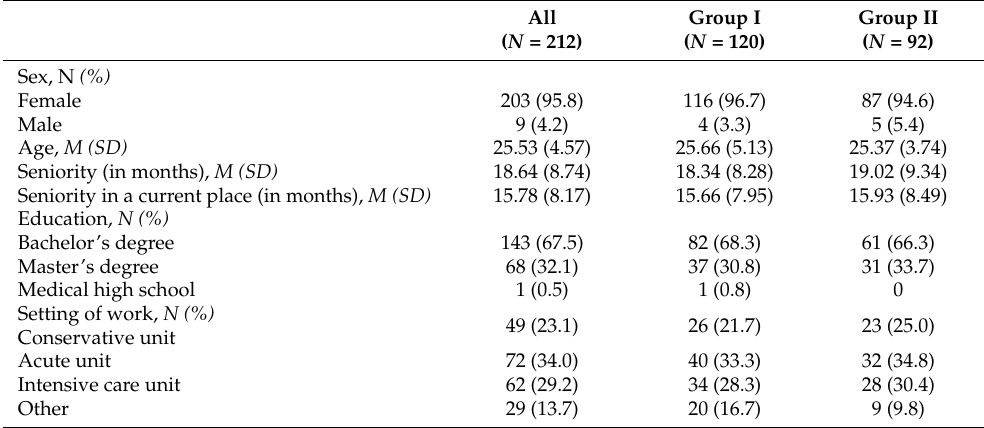
Table 1. The characteristics of the investigated group.